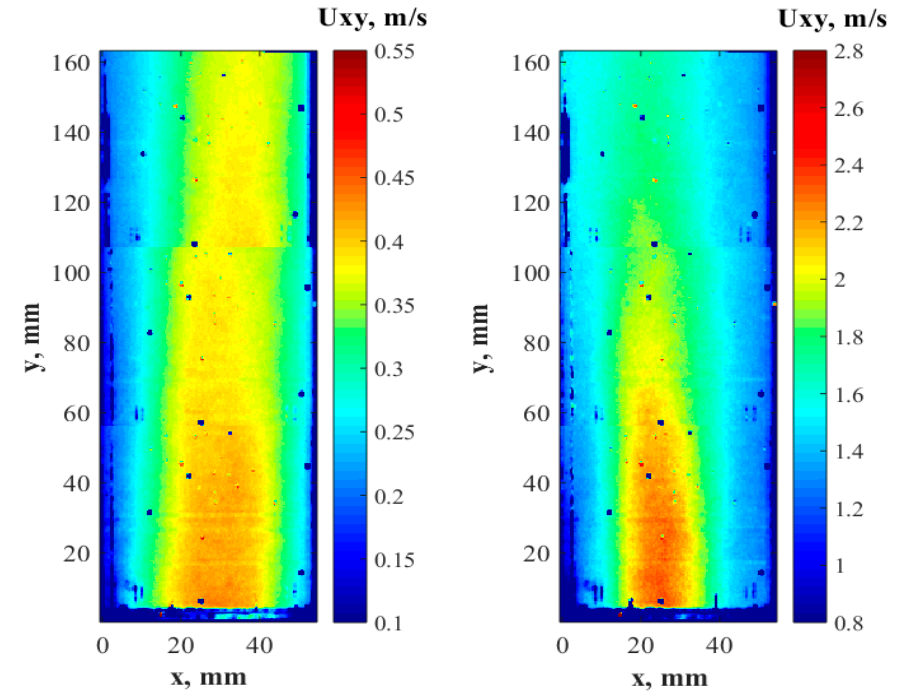
Figure 7. In-plane, time-averaged velocity contours of the fluid flow in the non-aerated CLR measured by PIV at 0.3 ( left ) and 1.4 m/s ( right ) inlet velocity.